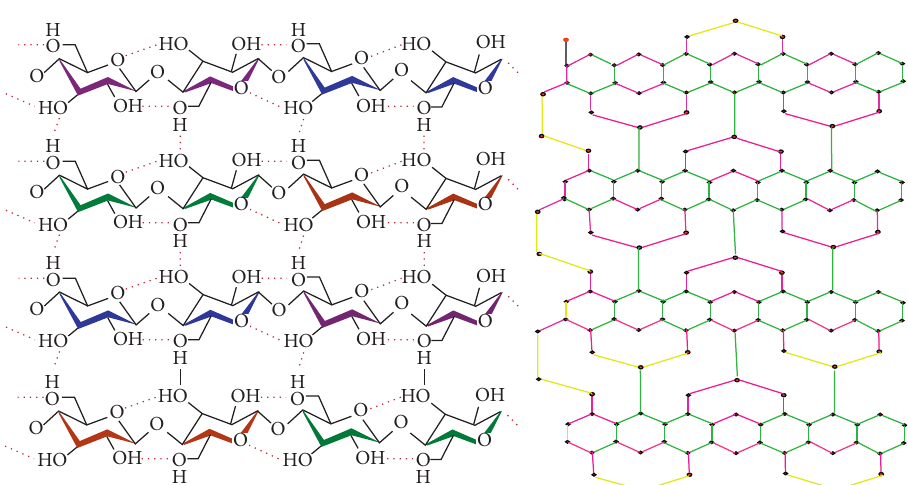
Figure 4: Chemical structure and equivalent molecular graph of cellulose CL 7